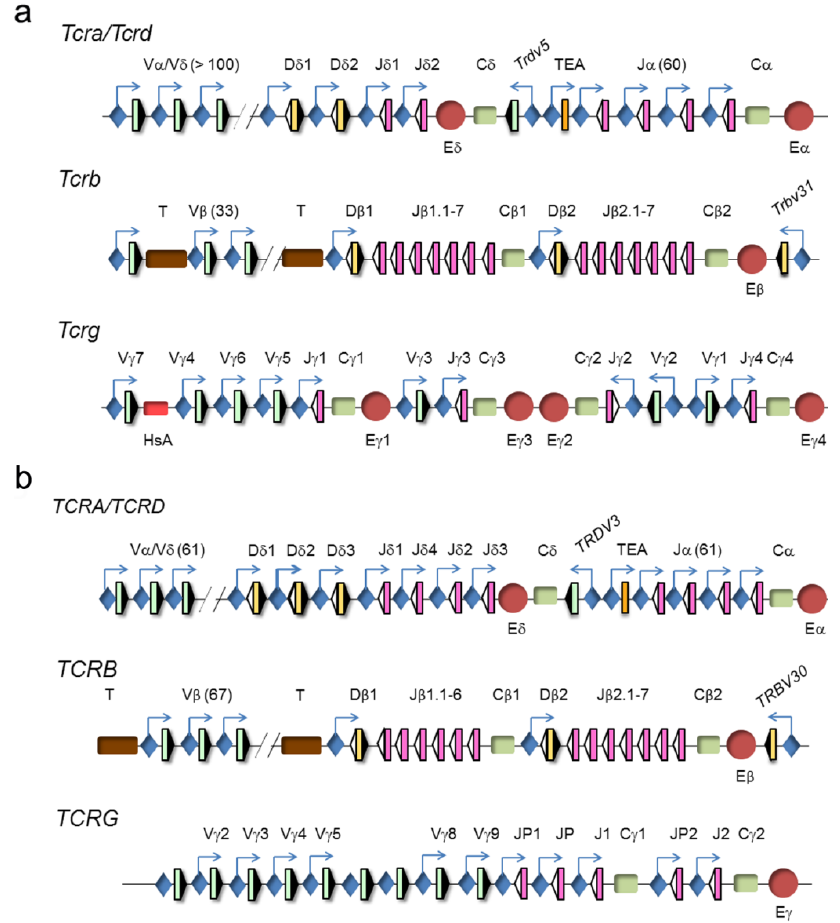
Figure 4. Genomic representation of mouse and human T-cell receptor (TCR) loci. ( a ) Murine and ( b ) human TCR α / TCR δ , TCR γ , and TCR β loci are represented. Variable (V), diversity (D), and joining (J) segments are indicated by green, yellow, and pink rectangles, respectively. Recombination signal sequences (RSSs) are represented by triangles adjacent to the V, D, and J gene segments (black: RSSs with a 12-bp spacer and white: RSSs with a 23-bp spacer). Constant (C) regions are represented as green rectangles. The T early α exon (TEA) is represented as an orange rectangle. Trypsinogen genes (T) are represented as brown rectangles. Enhancers are represented by red circles and promoters by blue diamonds, respectively. Germline transcription is indicated by blue arrows.